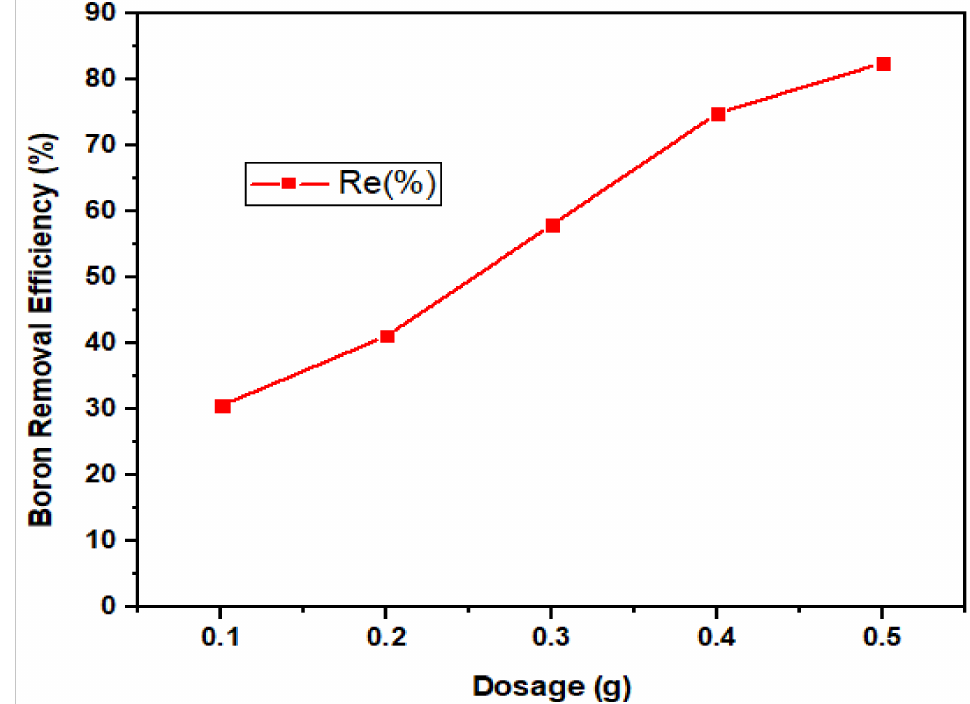
Figure 10. Boron removal efficiency by magnetite under variable dosages (0.1–0.5 g) at fixed pH (8) and contact time (180